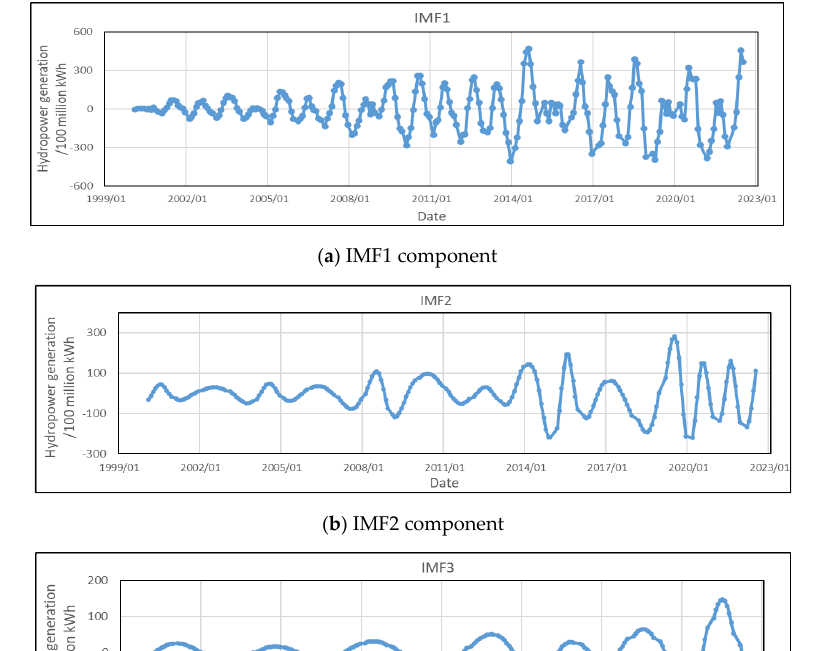
Figure 4. China’s hydropower generation data from 2000 to 2022.